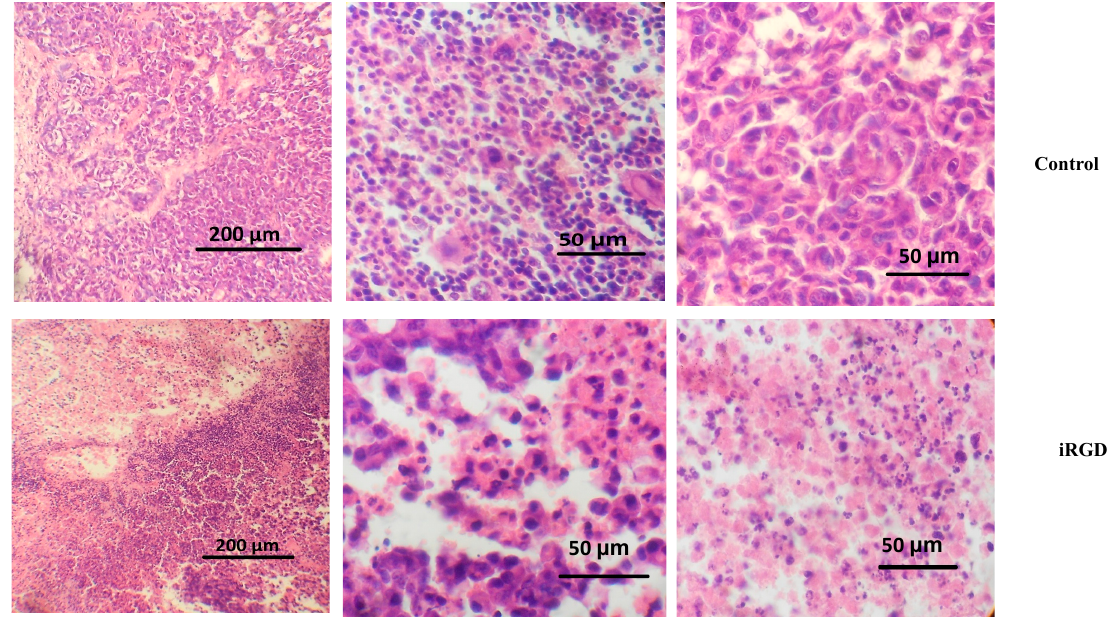
Figure 7. Histological analysis of TPP-IP treated breast cancer xenograft models. Tumor from control or iRGD-IP-treated mice were stained with hematoxylin/eosin and analyzed by microscopy. The scale bar is shown.